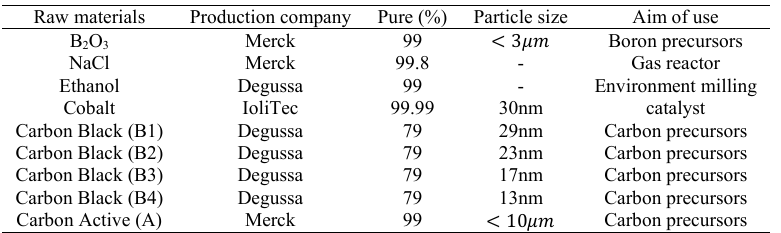
Table 1. The row materials and their characteristics